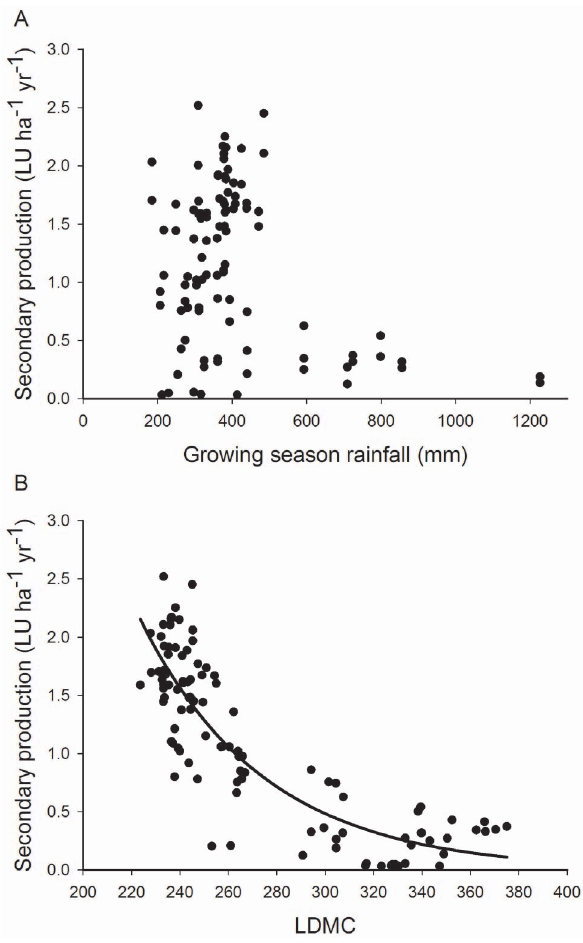
Figure 1. Productivity relationships. Fitted relationships between (A) rainfall (mm) and (B) leaf dry matter content (LDMC, mg g 2 1 ) and production (LU ha 2 1 yr 2 1 ).